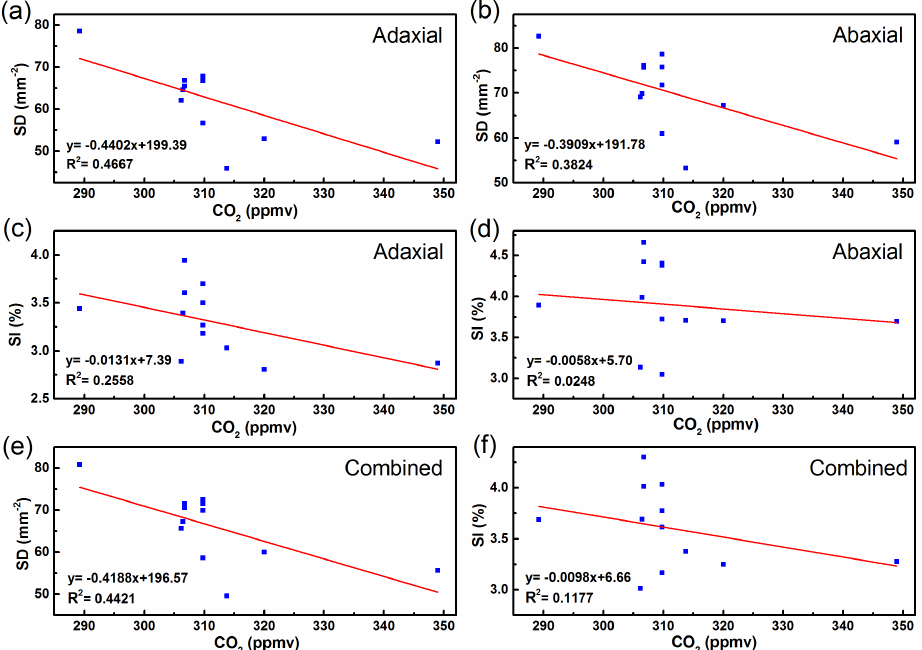
Figure 3. Correlation between SD and SI versus CO 2 concentration for modern Nageia motleyi . (a) Trends of SD with CO 2 concentration for the adaxial surface. (b) Trends of SD with CO 2 concentration for the abaxial surface. (c) Trends of SI with CO 2 concentration for the adaxial surface. (d) Trends of SI with CO 2 concentration for the abaxial surface. (e) Trends of SD with CO 2 concentration for the combined data of both leaf surfaces. (f) Trends of SI with CO 2 concentration for the combined data of both leaf